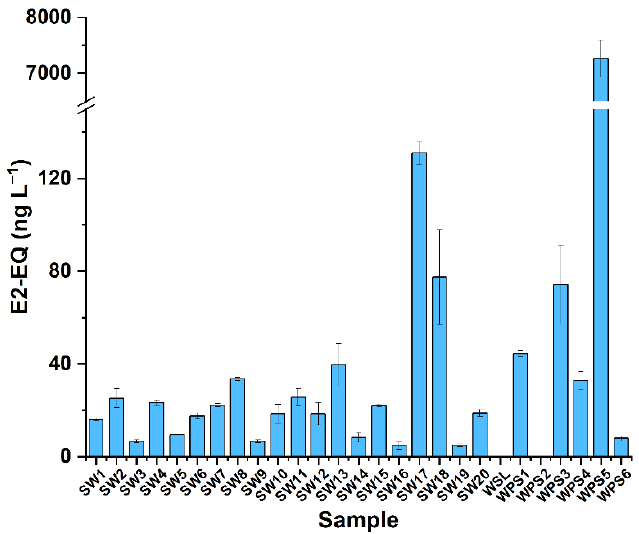
Figure 3. E2-EQ (ng L − 1 ) values of the samples determined using the YES assay. SW1–SW20 show the surface water samples; among these, SW16–SW19 were adjacent to a goose farm. WSL is the sample collected from a water source reservoir, and WPS1–WPS6 are the samples collected from possible pollution sources.